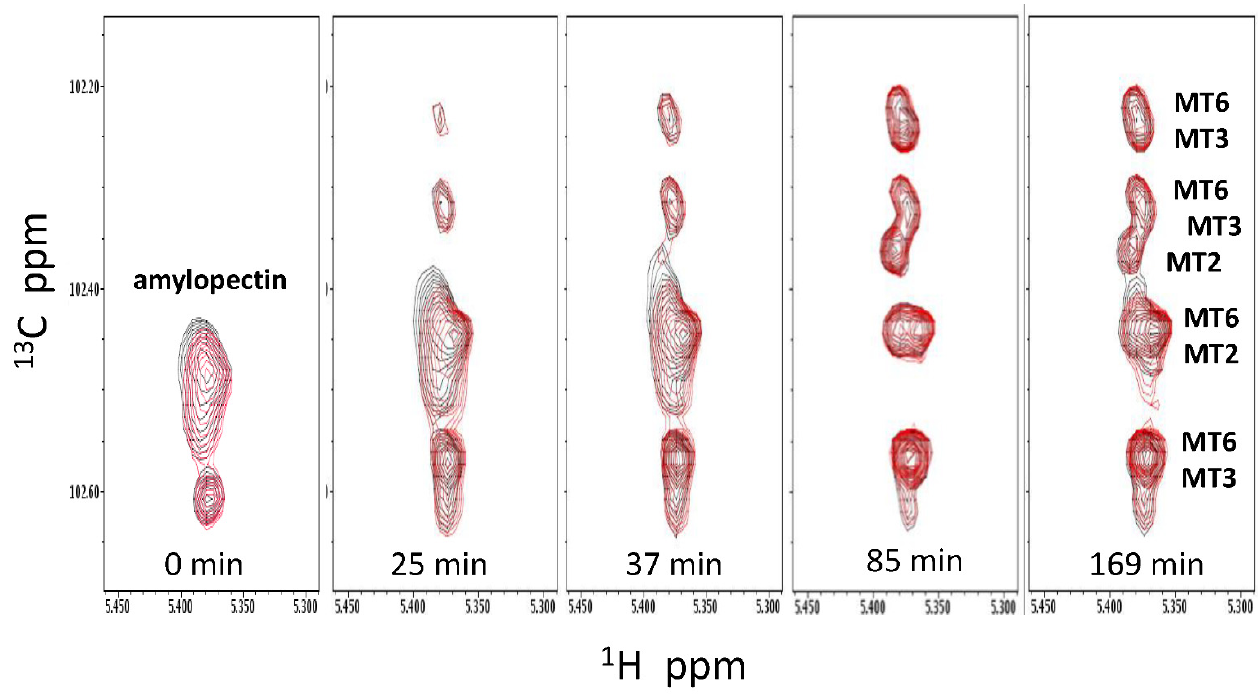
Figure 5. Natural abundance 13 C HSQC spectra (focused on acetal resonances) showing the time dependence of α -amylase-mediated (0.4 U/mL) hydrolysis of amylopectin in the absence (black contours) and presence (red contours) of PLG-007 (4.2 mg/mL). Resonances are labeled for maltose (MT2), maltotriose (MT3), and maltohexaose (MT6), as discussed in the text. Time points are indicated on the figure. Solution conditions are 20 mM potassium phosphate, pH 7, 30 °C.